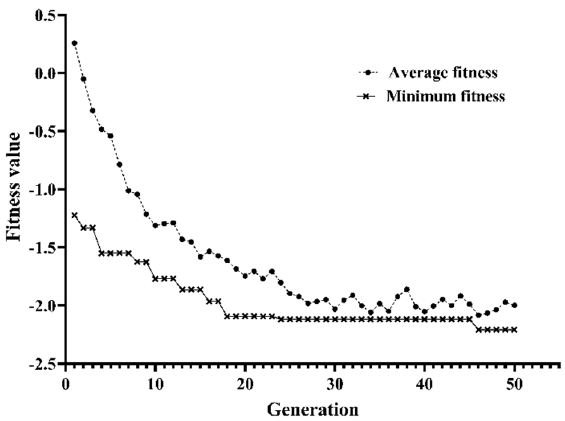
Figure 9. Average and minimum fitness variation during the operation of the algorithm.